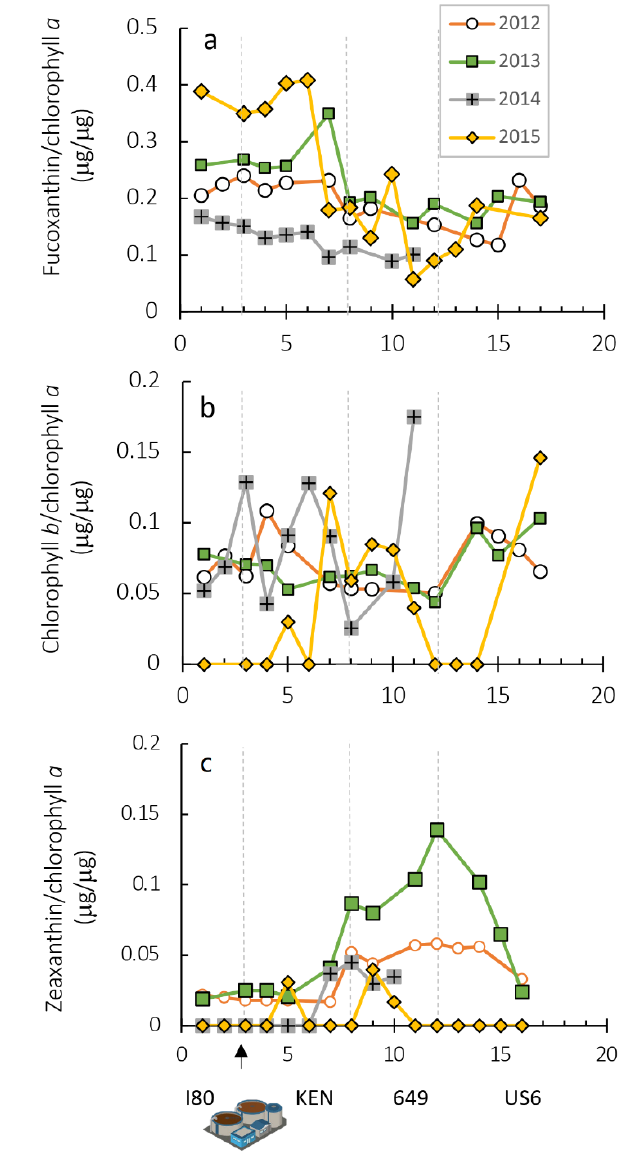
Figure 8. Transects of fucoxanthin/chlorophyll a (indicative of diatoms, panel a ), chlorophyll b /chlorophyll a (indication of green algae, panel b ) and zeaxanthin/chlorophyll a (indicative of cyanobacteria, panel c ) for the years of sampling undertaken in the Bay Delta during September/October prior to WWTP upgrade. Vertical dashed lines separate the major segments of the river/estuary. The WWTP icon shows location of discharge.